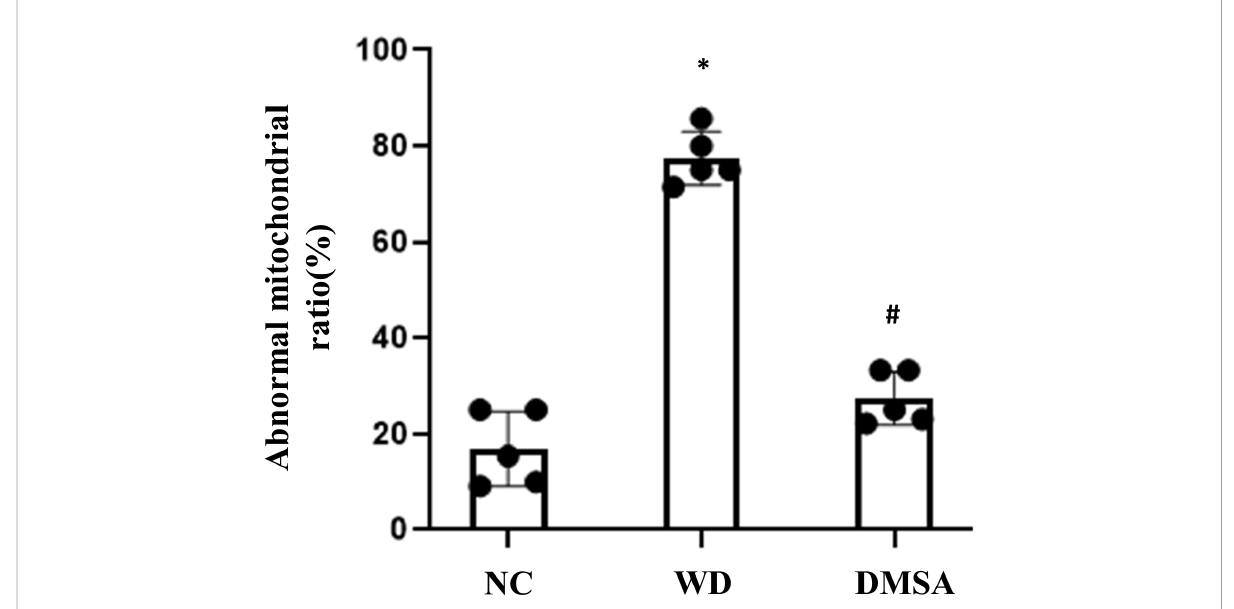
FIGURE 5 Ratio of abnormal mitochondria in pituitary gonadotropin cells. Data are presented as mean ± SD.(*P<0.05, NC group vs. WD group; # P<0.05, WD group vs. DMSA group).